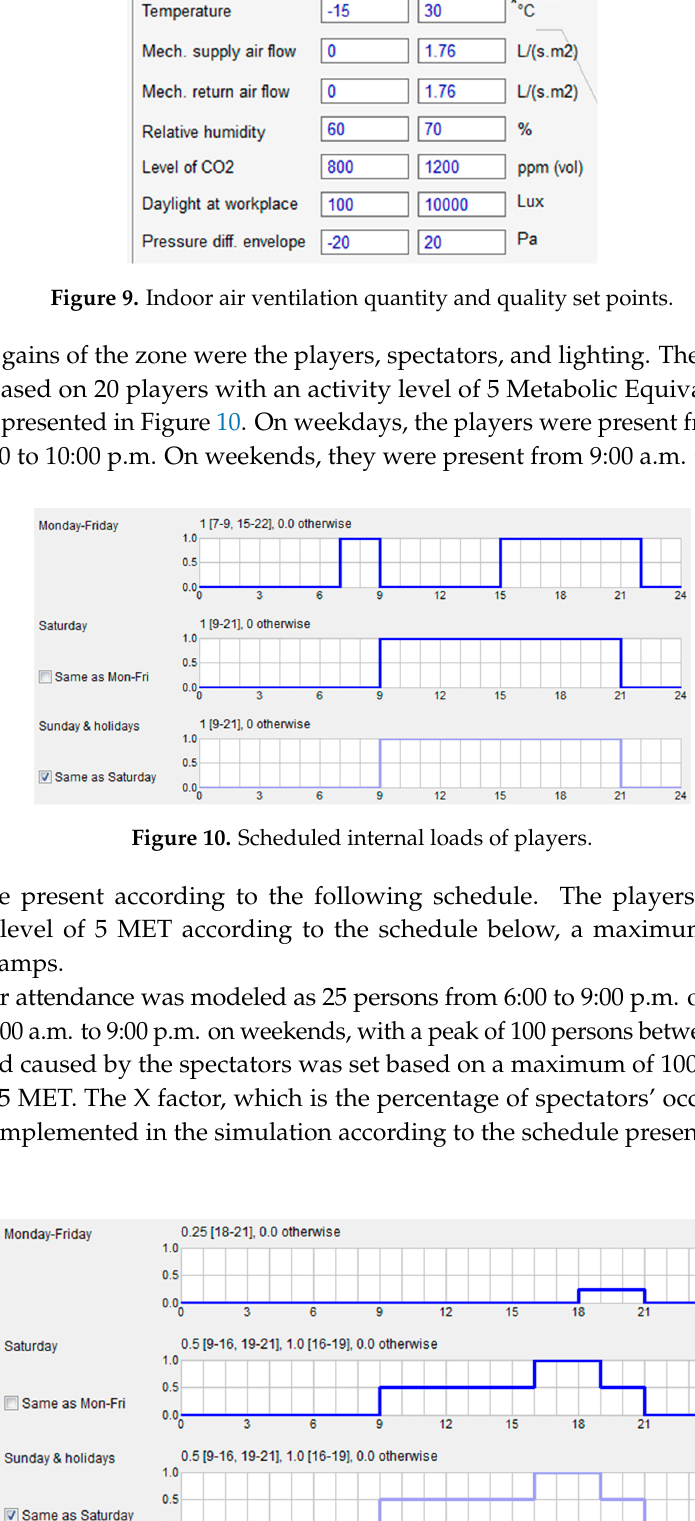
Figure 11. Scheduled internal loads of spectators.